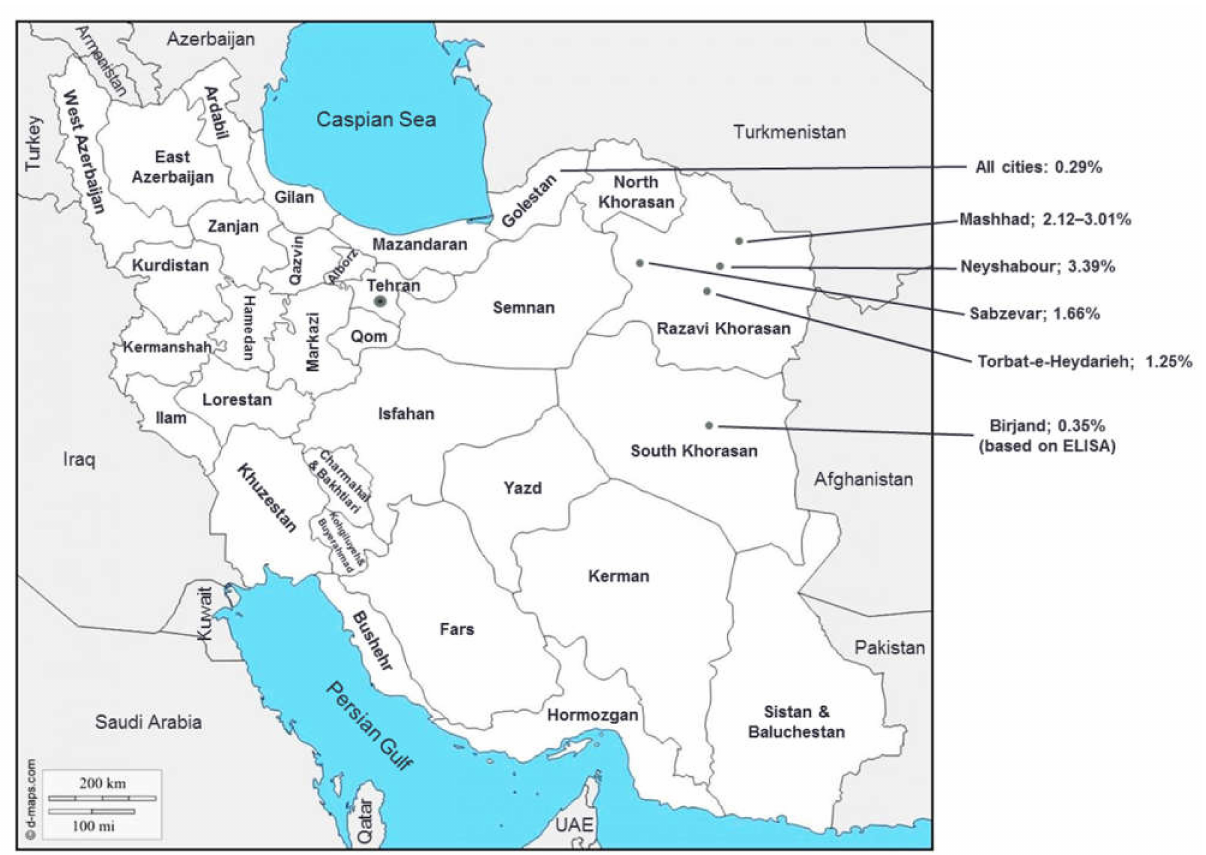
Figure 2. General population-based reports of HTLV-1 infection prevalence in Iran (References [19–24,30], source of background map: https://d-maps.com/carte.php?num_car=5494&lang=en, accessed on 12 February